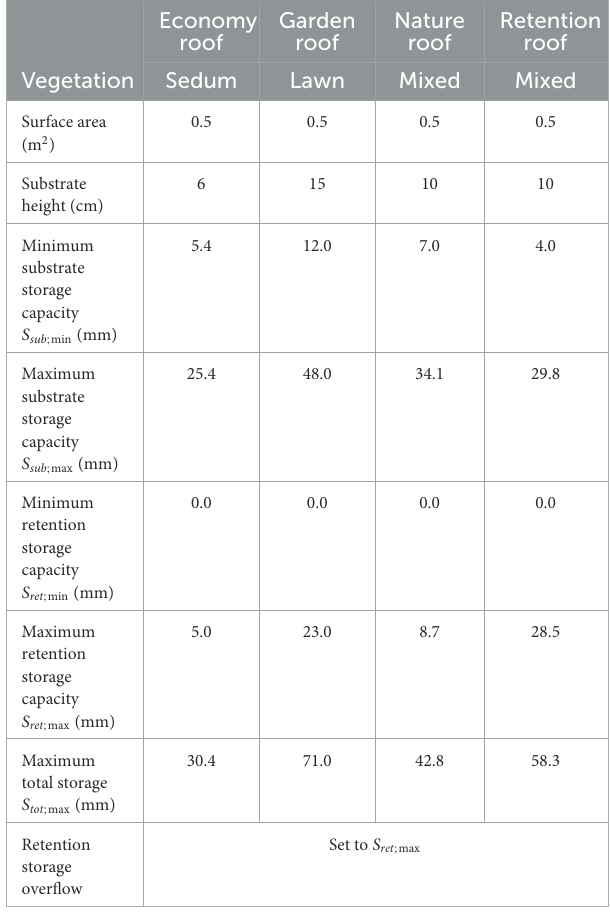
The lysimeters were located at the Optigrün premises in Göggingen (Germany) and instrumented to record weight and outflow at 5-min intervals from April 1 to October 5, 2021. Precipitation and temperature data were collected on site. The exact study set-up, data collection, and a comparative study of evapotranspiration rates are explained in Gößner et